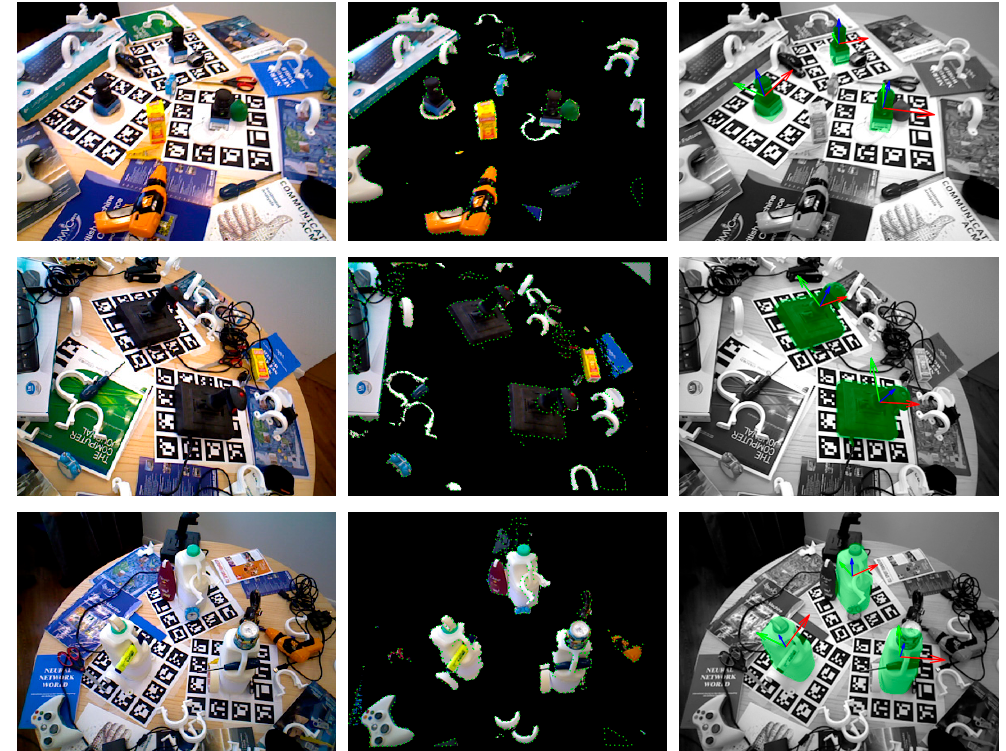
Figure 9. Some detection results on the Tejani dataset. Table 1. F1-scores of methods on the Tejani